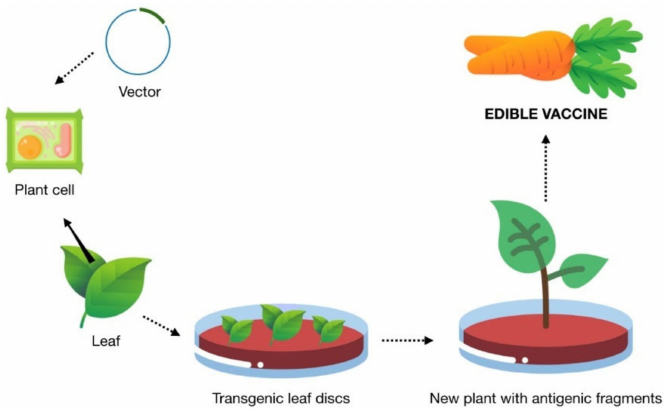
Figure 7. Development of edible vaccines. Icons made by Freepik and Smashicons from www.flatico n.com (accessed on 1 December 2021). Adapted from